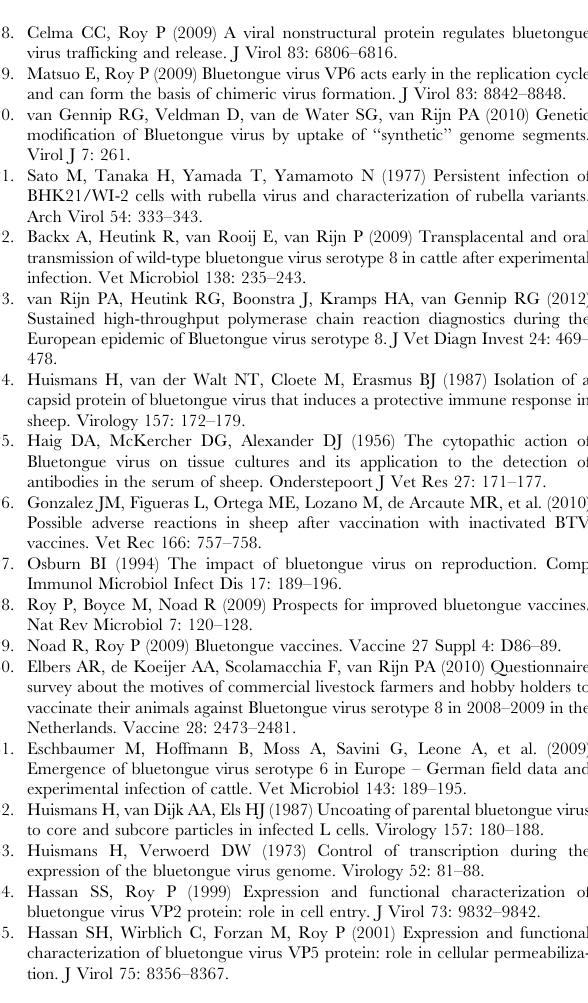
Table S1 Clinical score table BTV animal trial. The